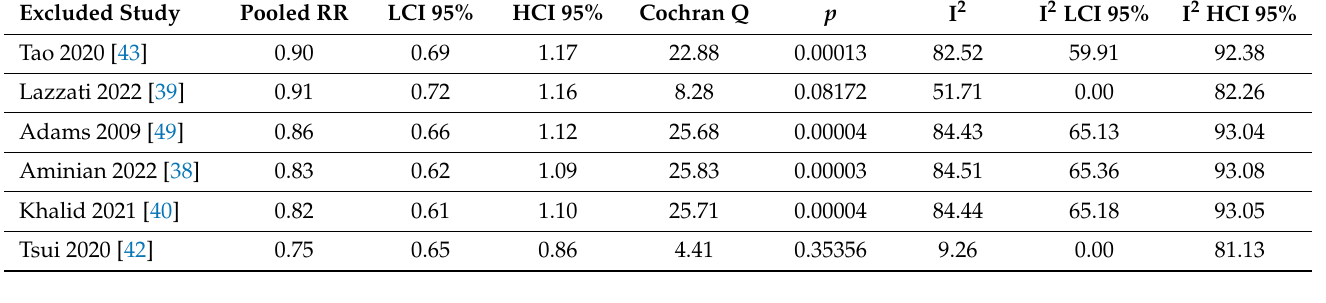
Table A18. Thyroid cancer random e ff ects model sensitivity analysis.